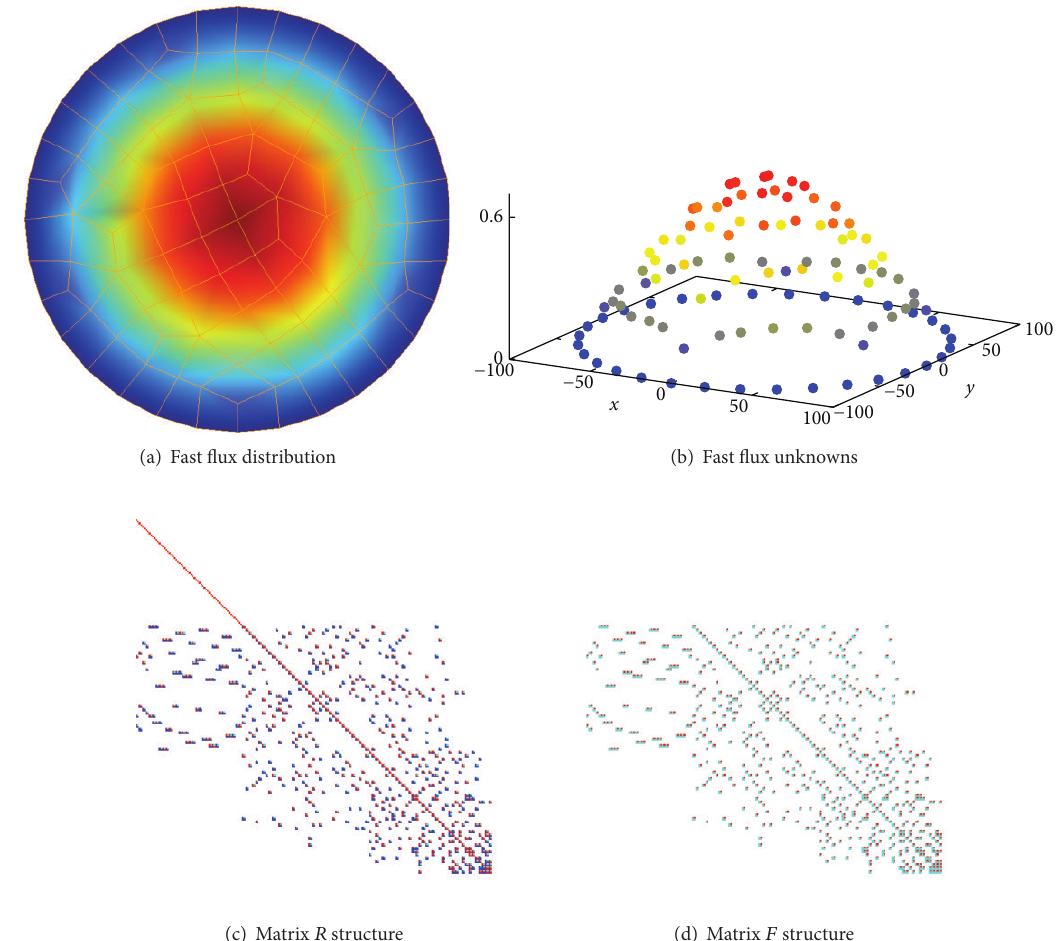
Figure 6: A bare homogeneous circle solved with finite elements (218